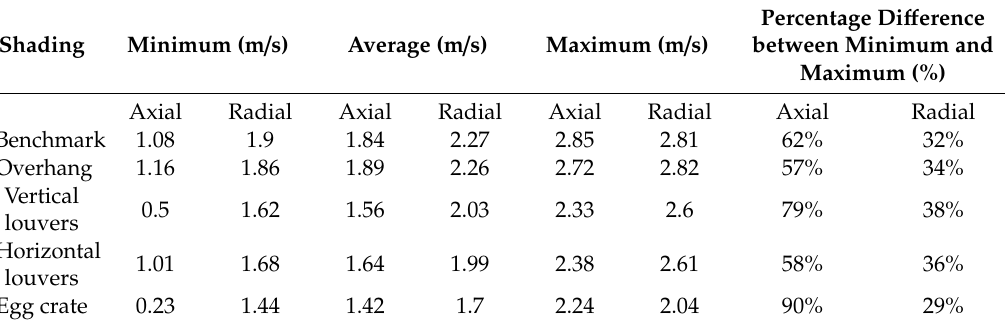
Figure 10. Velocity profile for Radial direction (CFD).